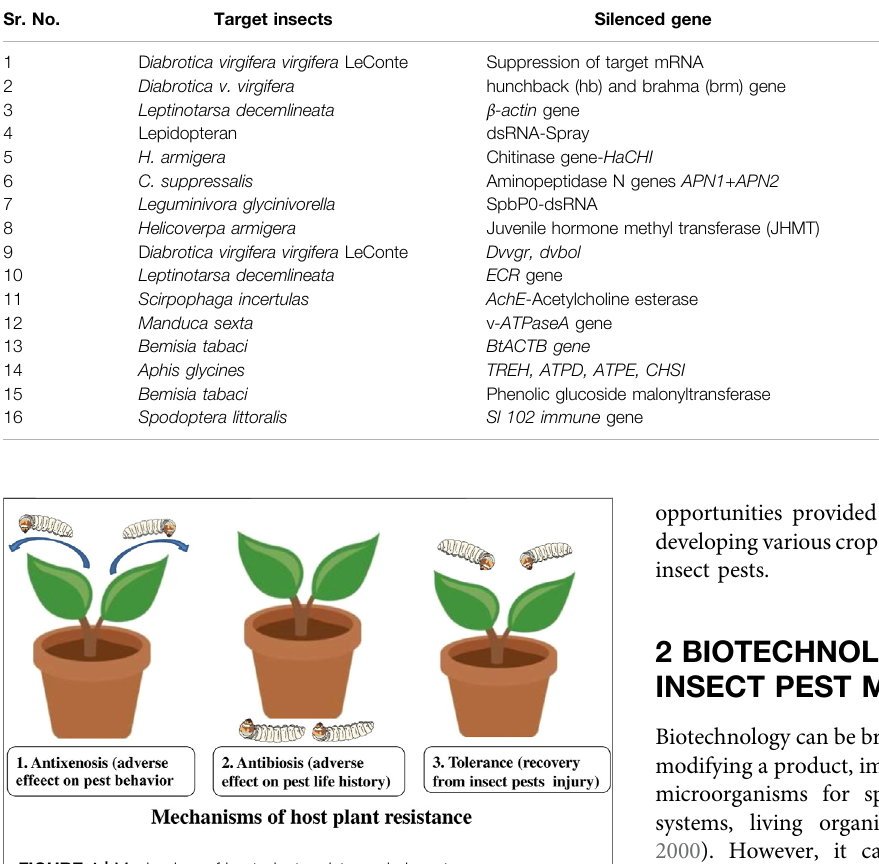
FIGURE 1 | Mechanism of host plant resistance in